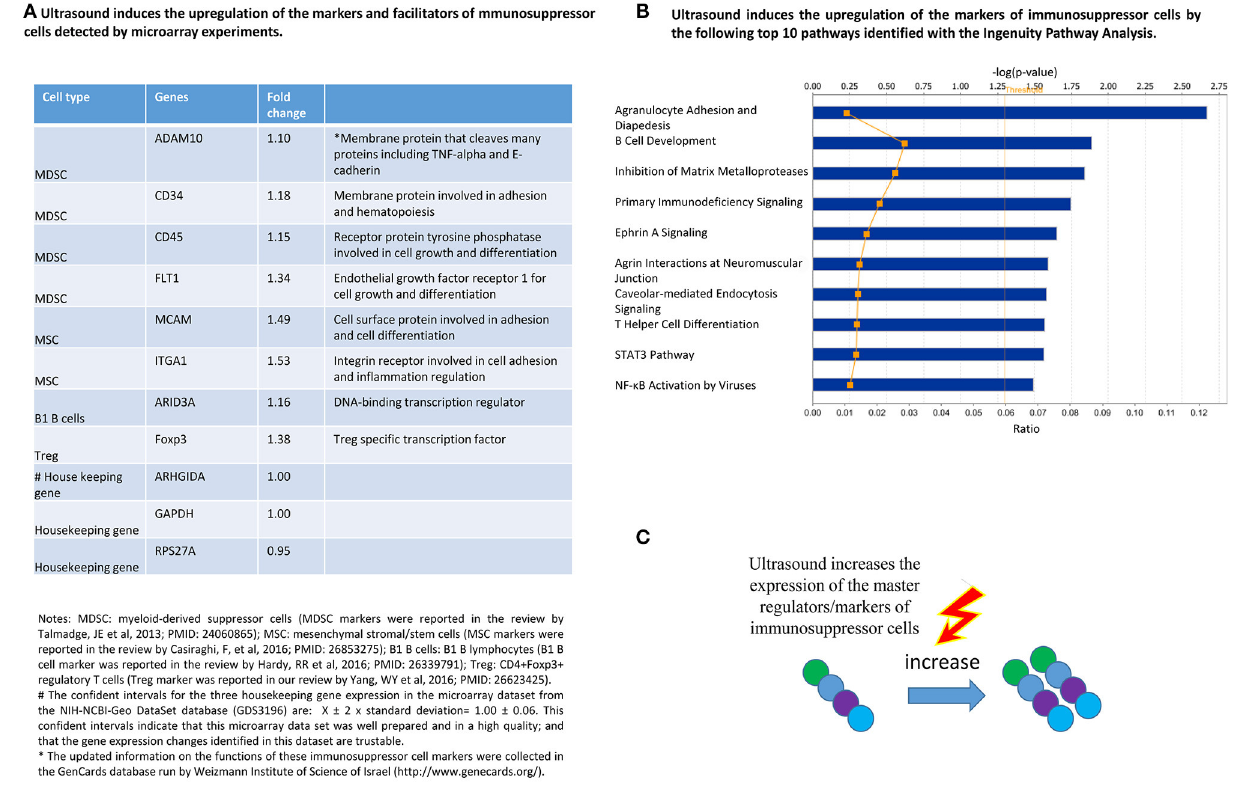
Frontiers in Physiology |